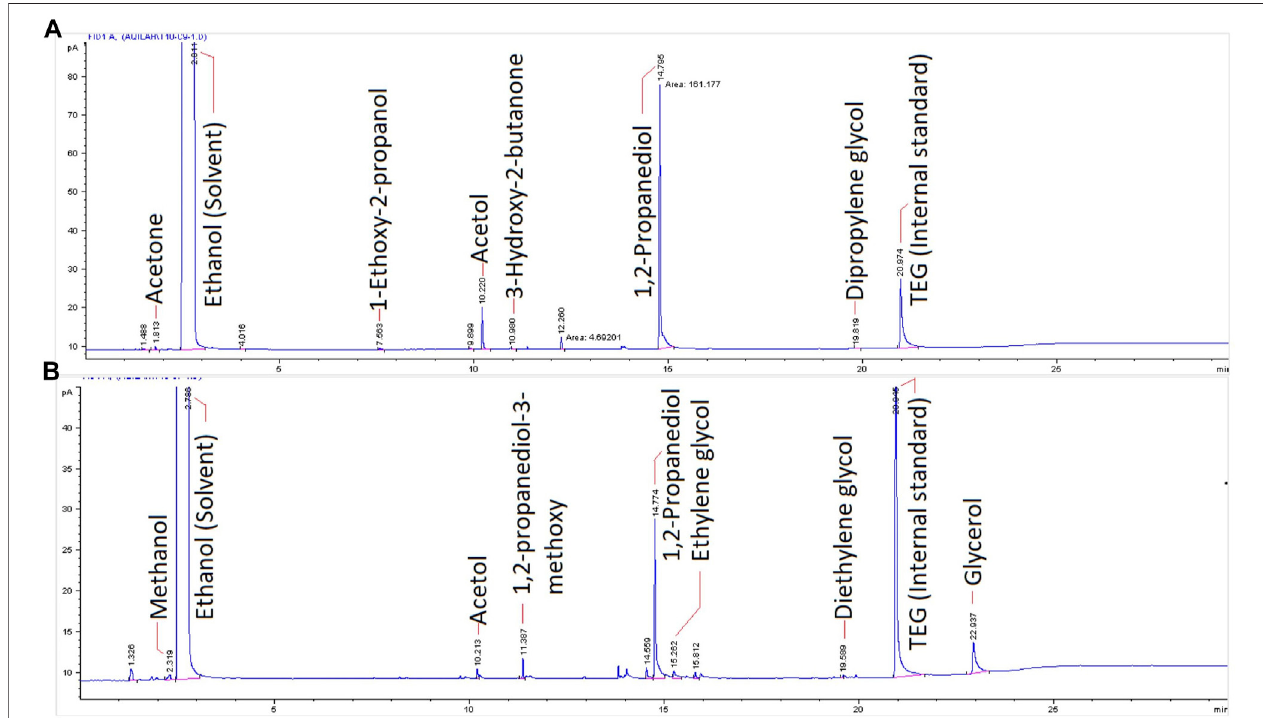
FIGURE 1 | GC chromatograms after 8 h of (A) acetol electrolysis and (B) glycerol electrocatalytic reduction.